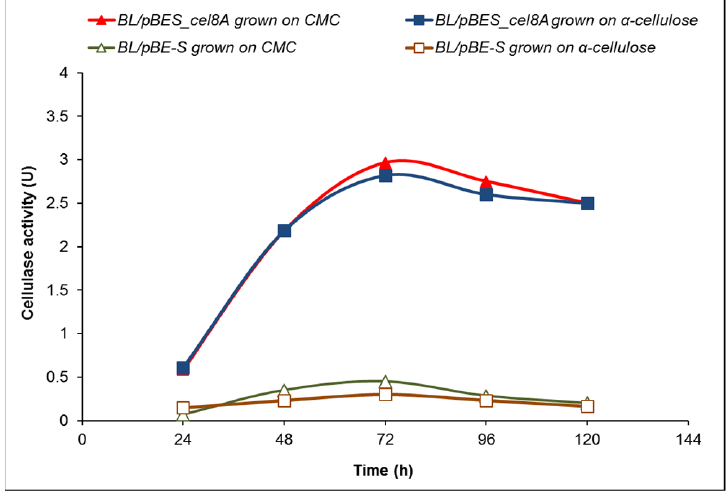
Figure 3. Time course of cellulase activity of B. licheniformis 24, containing the expression vector